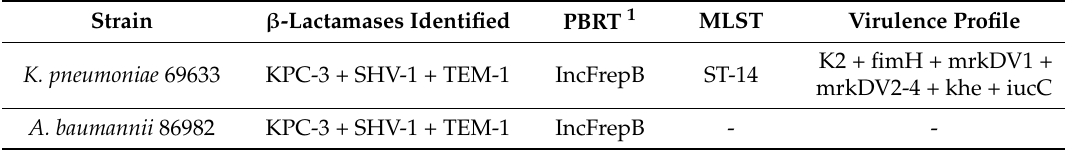
1 Legend: PBRT: PCR-based replicon typing; MLST: multilocus sequence